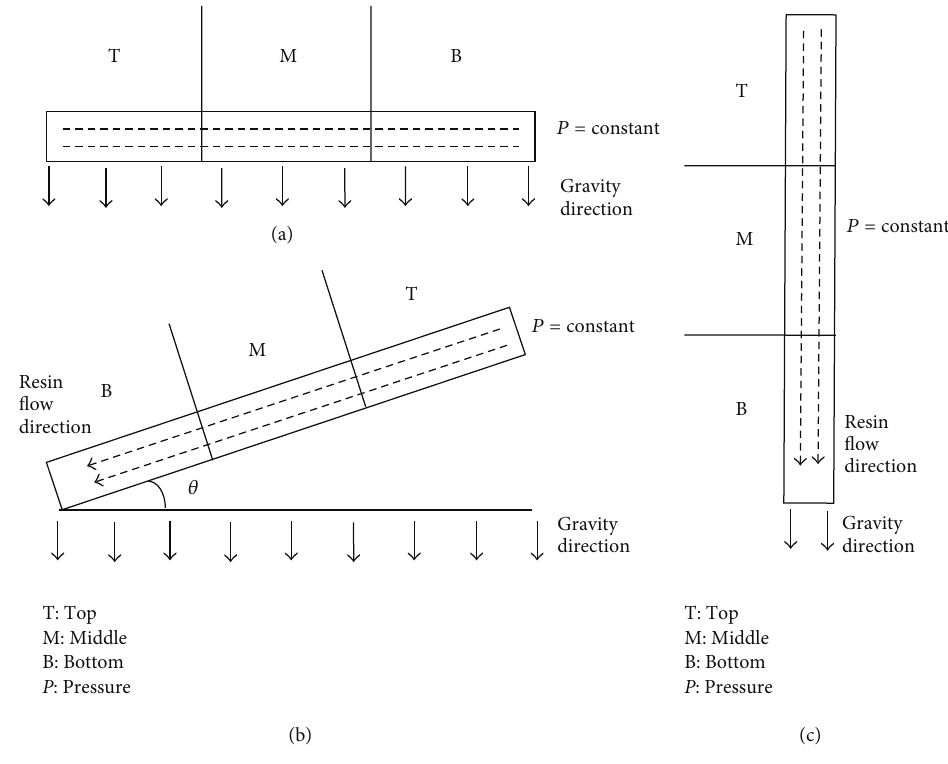
Figure 7: Laminated composite cured at (a) 0 ∘ , (b) 10 ∘ –80 ∘ , and (c) 90 ∘ .